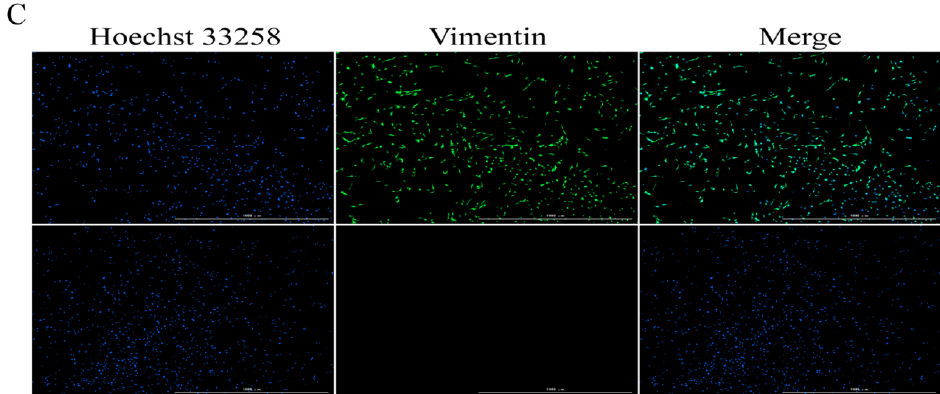
Figure 1. Identification of Sertoli cells. ( A ) The short arrow indicates bipolar bodies and the long arrow indicates lipid droplets, at ×40 magnification. ( B ) Expression of SOX9 and GATA4 mRNA. ( C ) The nucleus was counterstained with Hoechst 33258 and green fluorescence indicates vimentin positive (×4 magnification). N = 3 for both. The immunofluorescence results showed that vimentin was positive in the Sertoli cells and the proportion of positive cells reached 94%, which can be used in subsequent experiments (Figure 1C).